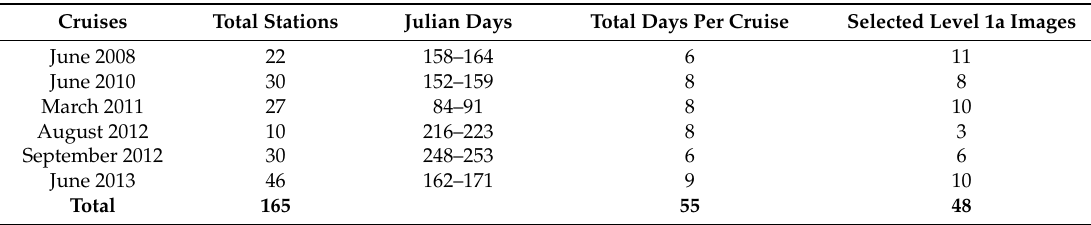
Table 2. General information on the in situ database analyzed and effective monitoring days used for the extraction of Level 1A